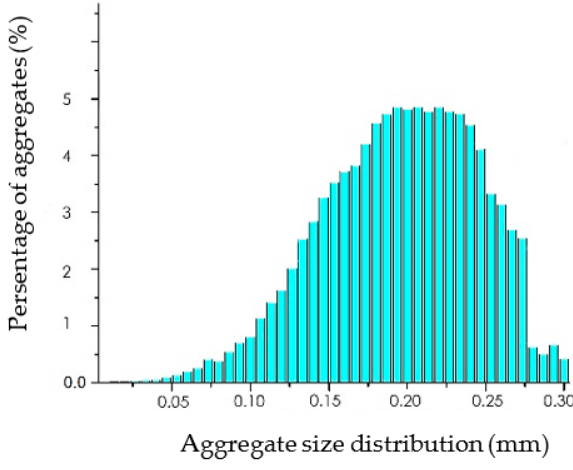
Figure 10. Aggregate size distribution for PA nanocomposite filament.